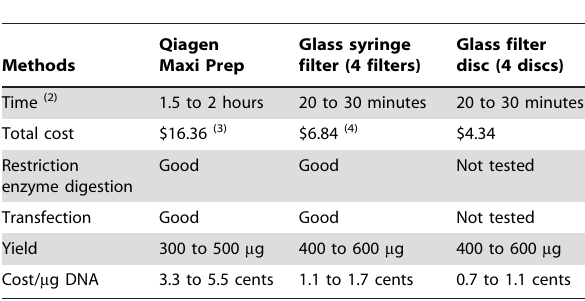
Table 1 . Comparison (1) of the three plasmid purification